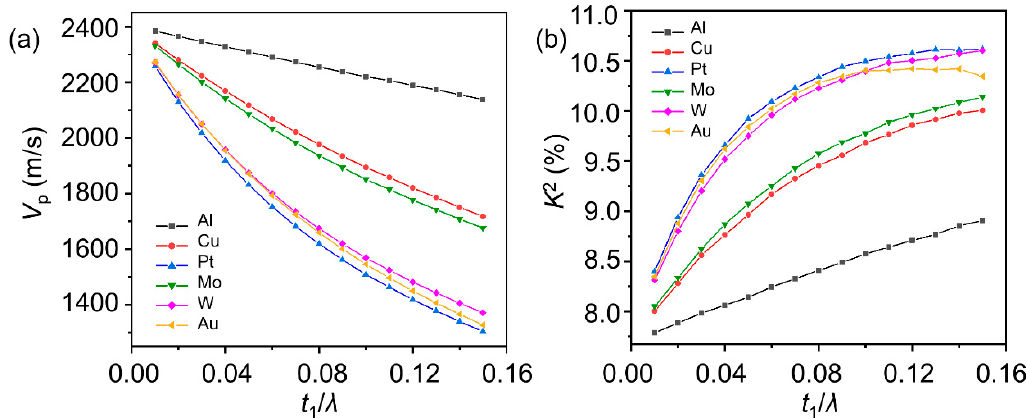
Figure 4. V p ( a ) and K 2 ( b ) of quasi-Rayleigh waves as functions of top electrode thickness t 1 / λ based on the partially etched ZnO/SiC structure when the etching ratio d / h = 1 and ZnO thickness h / λ = 0.5.